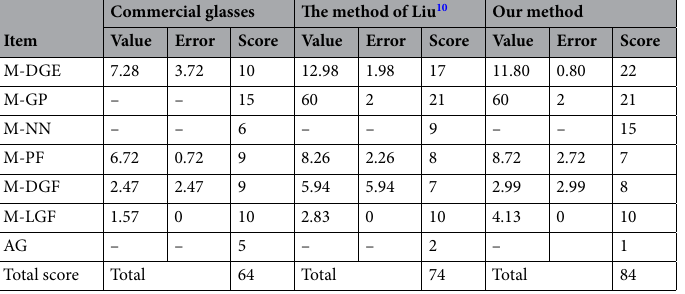
Table 6. GFS of example 2 with the commercial glasses, the Liu 10 method, and our method.